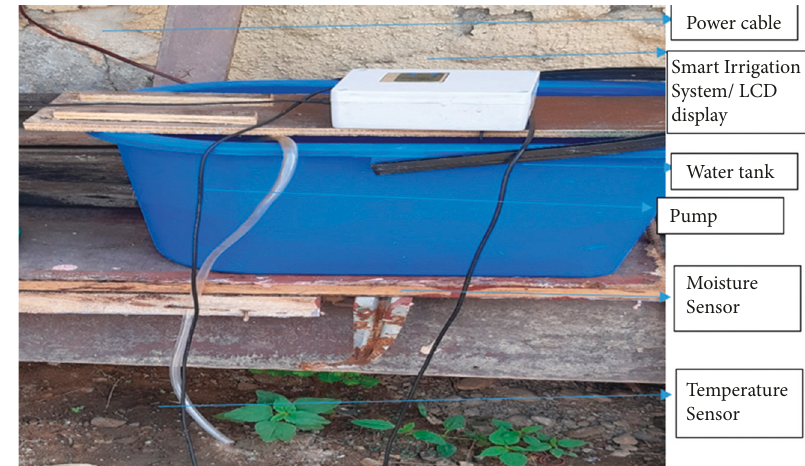
Figure 11: The working prototype of the